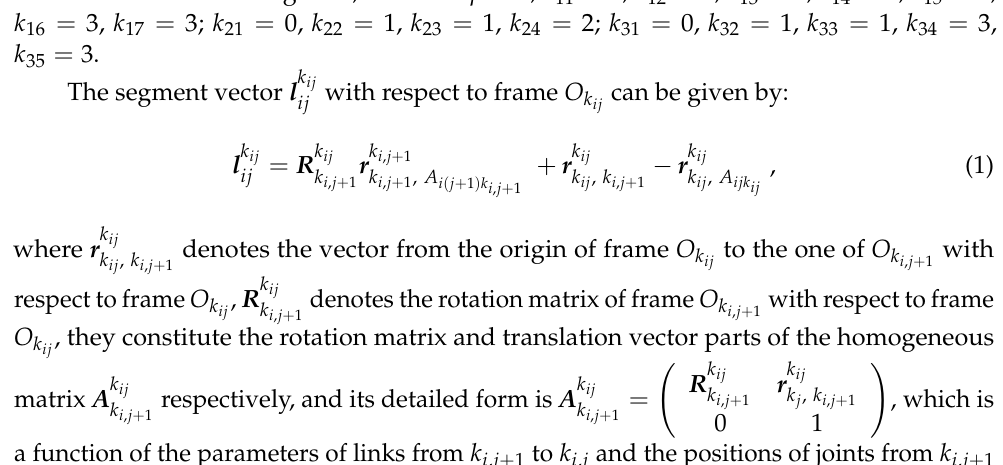
same link, the homogeneous matrix becomes an (4 × 4) identity matrix.